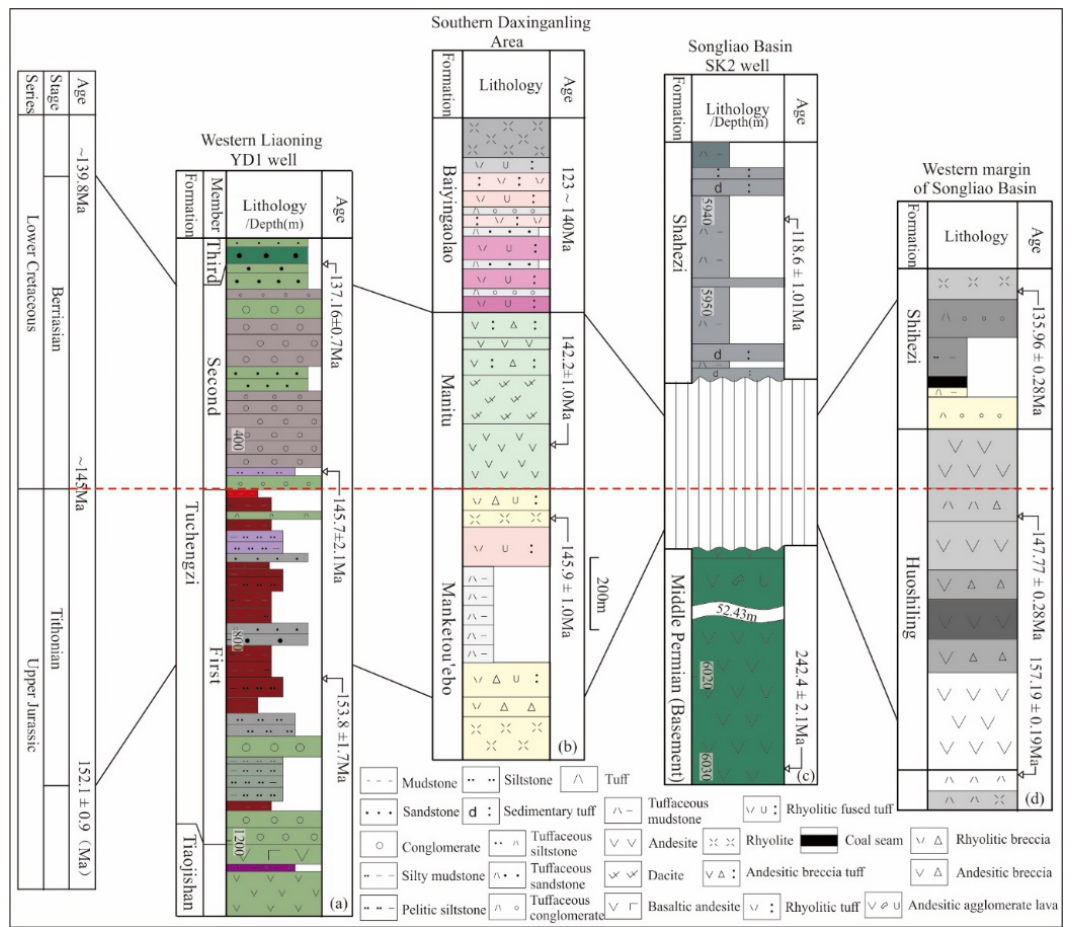
Figure 6. Potential layer comparison of terrestrial Jurassic–Cretaceous boundary in Northeast China. ( a ) Western Liaoning YD1 well; ( b ) Southern Daxinganling area; ( c ) Songliao Basin SK2 well; ( d ) Western margin of Songliao Basin.